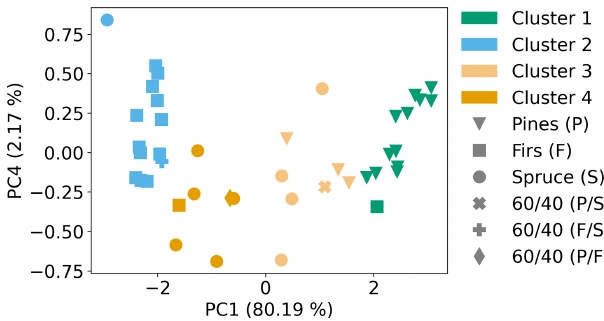
Figure 10. PCA coupled with k -means clustering results for the PC1 and PC4 pair, including the 60%/40% synthetic mixtures.